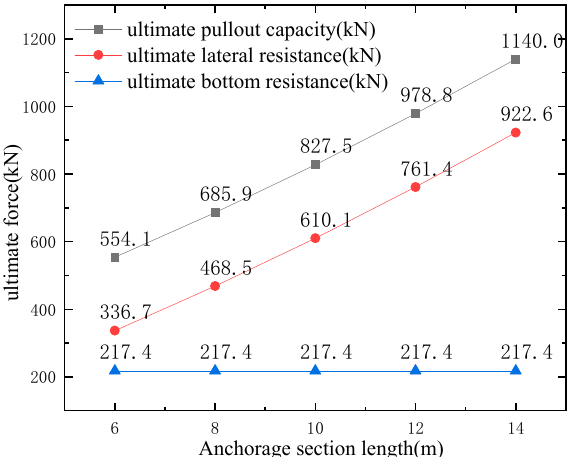
Figure 17. The ultimate force variation curves according to an increase in the anchorage segment length.